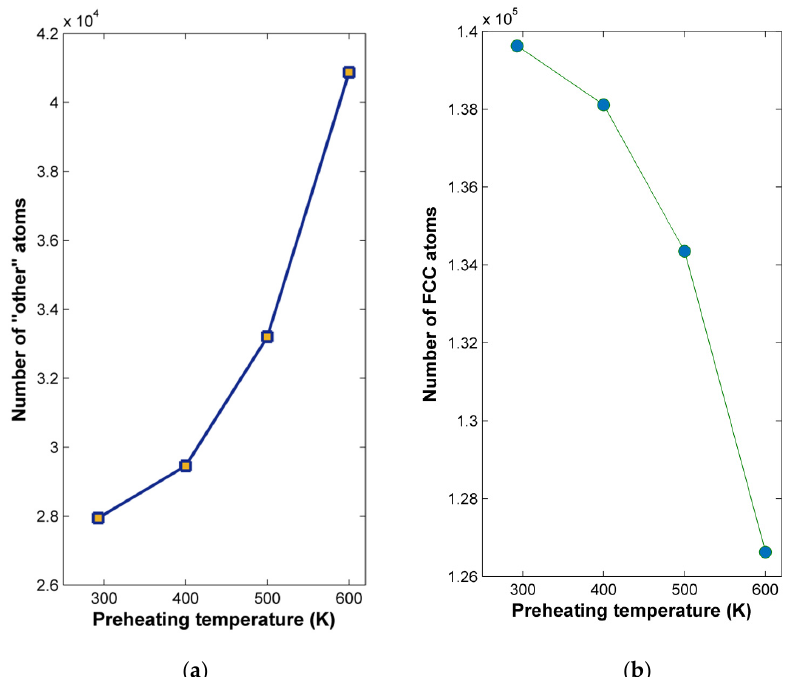
Figure 14. Variation of: ( a ) “other” atoms and ( b ) fcc atoms with respect to preheating temperature.